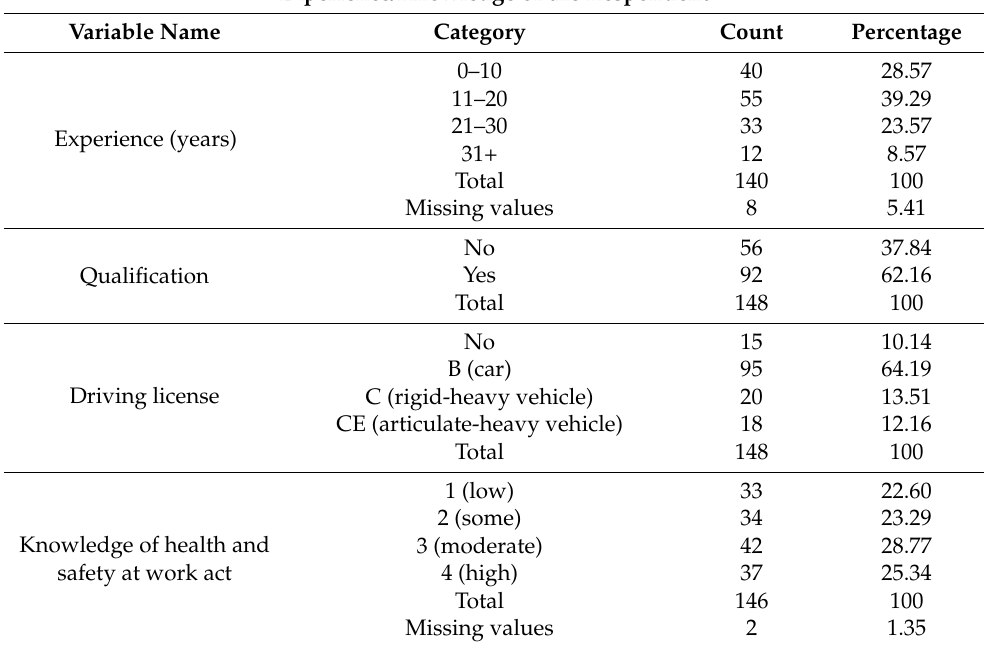
Table 3. Frequency table of the replies ( n = 148) to the experience/knowledge of the respondent in a survey on horse road transport practices, transport-related problem behaviors, horse injuries, and horse handler injuries in